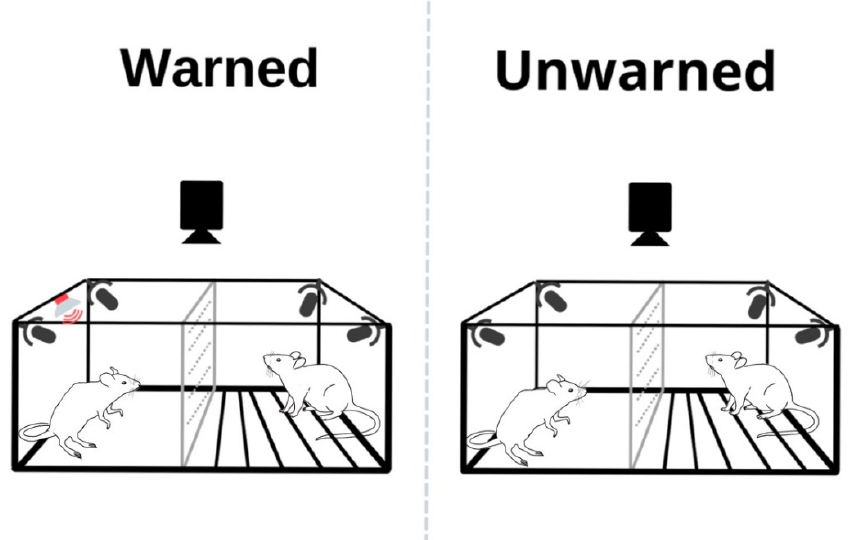
Figure 3. Illustration of the test session. To exclude the rats’ aversive conditioning response, the test cage differed from the training cage in terms of smell, light intensity, and shape. Depending on the experimental group, ‘warned’ or ‘unwarned,’ a 1.75 kHz sound signaling a foot shock was delivered or not delivered, respectively.